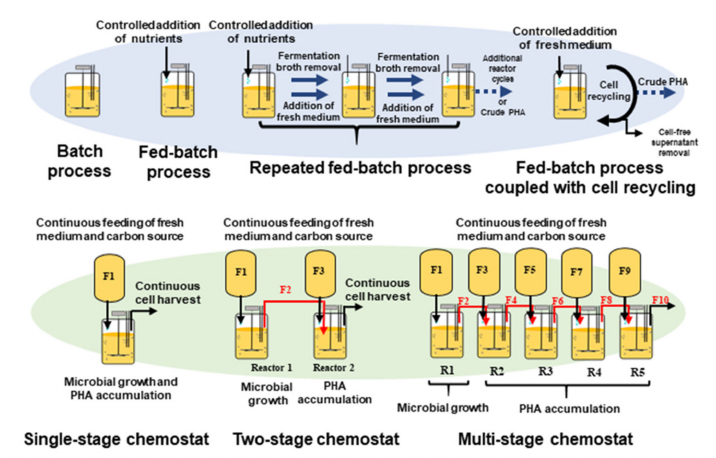
Figure 4. Process regimes for PHA fermentative